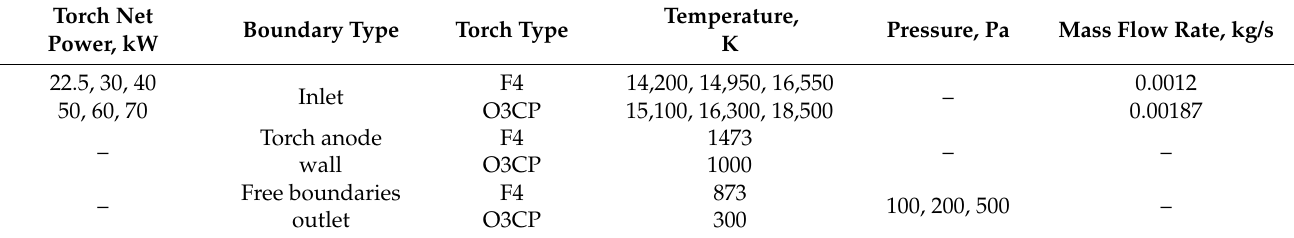
Table 3. Boundary conditions used in the CFD model.